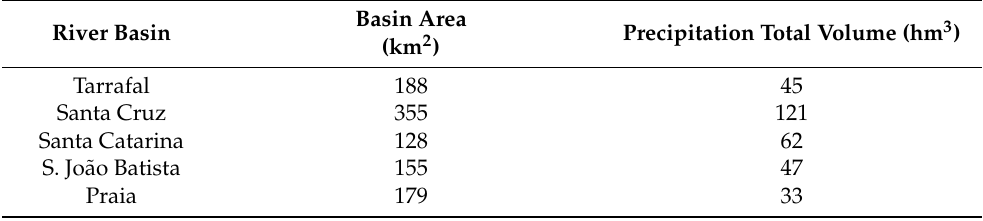
Table 2. The main river basins of Santiago Island total area and precipitation volumes (adapted from